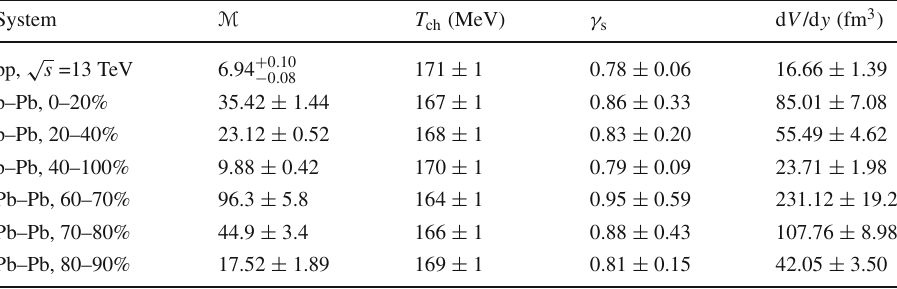
in the upper panels represent the model calculations and their system- atic uncertainty as described in the text. The r core and r eff values of the source are reported with their statistical and systematical uncertainties, respectively. Bottom panels represent the data-to-model comparison as described in the text